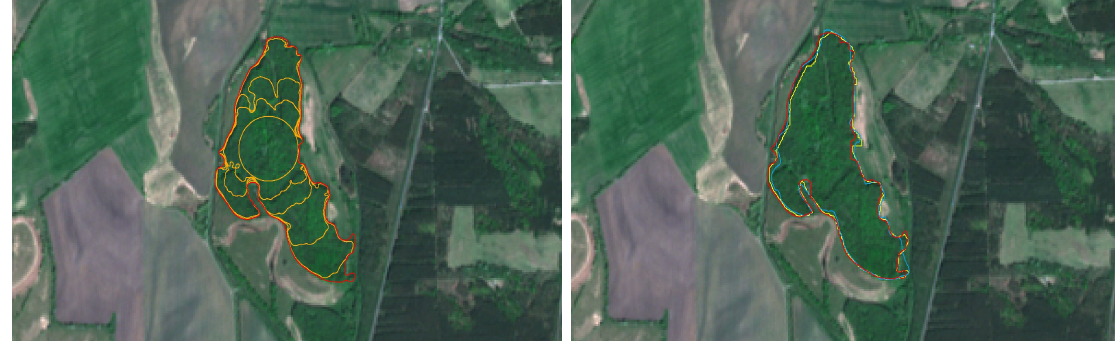
Figure 5. Example of the automatic segmentation applied to the riparian forest Natura 2000 habitat in Záhorie PLA. Left: the evolution of the segmentation curve from the initial circle (around phytosociological relevé) to the final state. Right: the final automatic segmentation (red) together with the result of the semi-automatic segmentation (yellow) and the GPS track (light-blue).